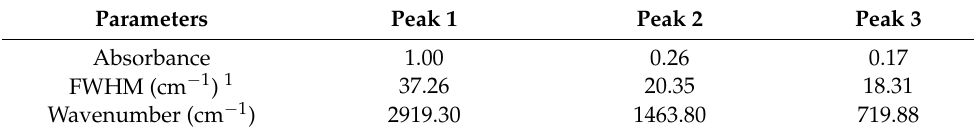
Table 3. Characteristics of the most significant spectral bands of the wax (normalized peaks).